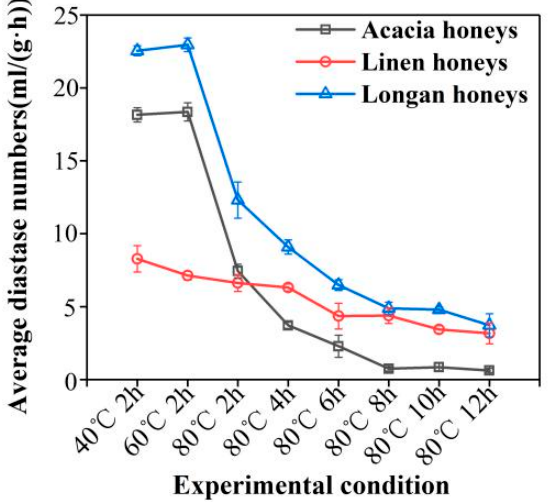
Figure 1. DN of the heat-treated honeys. Changes of diastase number in acacia, linen and longan honeys with different heating conditions.